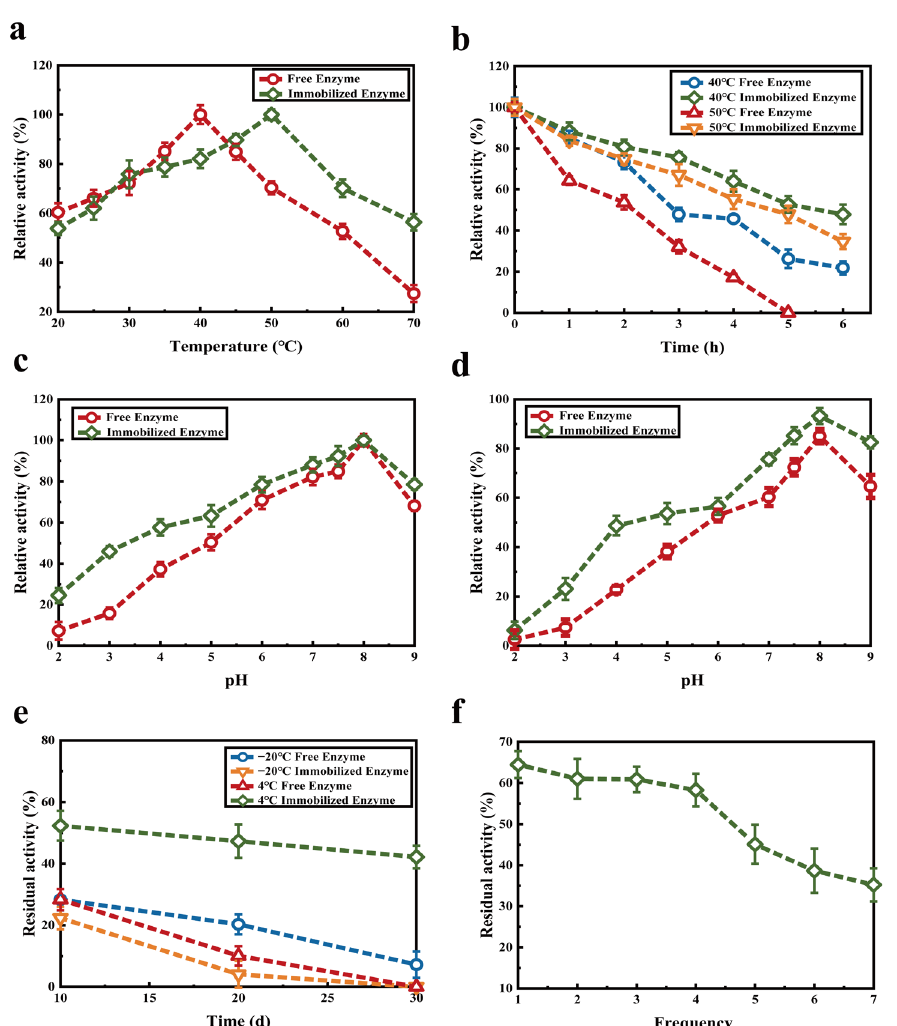
Figure 11. Storage stability test of immobilized enzyme. ( a ) Effect of temperature on the activity of immobilized enzyme; ( b ) thermal stability of immobilized and free enzymes; ( c ) effect of pH on immobilized enzyme activity; ( d ) pH stability of immobilized and free enzymes; ( e ) storage stability of immobilized and free enzymes at − 20 °C and 4 °C; ( f ) operational stability of immobilized en-